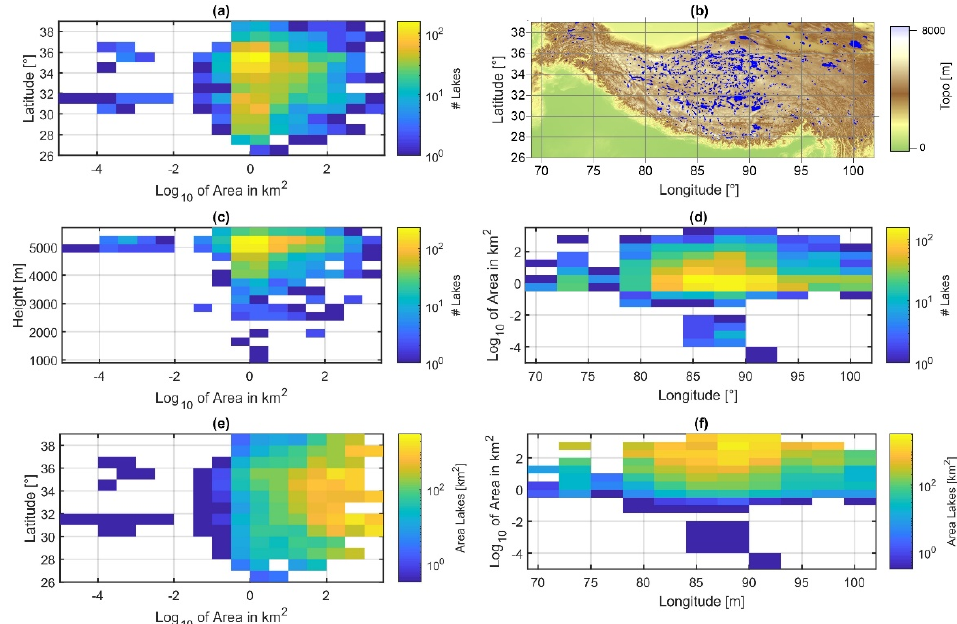
Figure 5. Statistical distribution of lakes in the Tibetan plateau. The spatial distribution of lakes is shown in plot ( b ), while plots ( a , d ) report the numerosity ‐ size distribution as functions of latitude and longitude, respectively. Plot ( c ) illustrates the distribution of lakes as function of height. Finally, plots ( e , f ) are calculated by multiplying the histogram ( a ) by the area of each bin. From these last two plots we see that most of the areal coverage is due to lakes with areas > 10 km 2 . In plots ( a , b , d ), “# Lakes” stands for number of lakes.